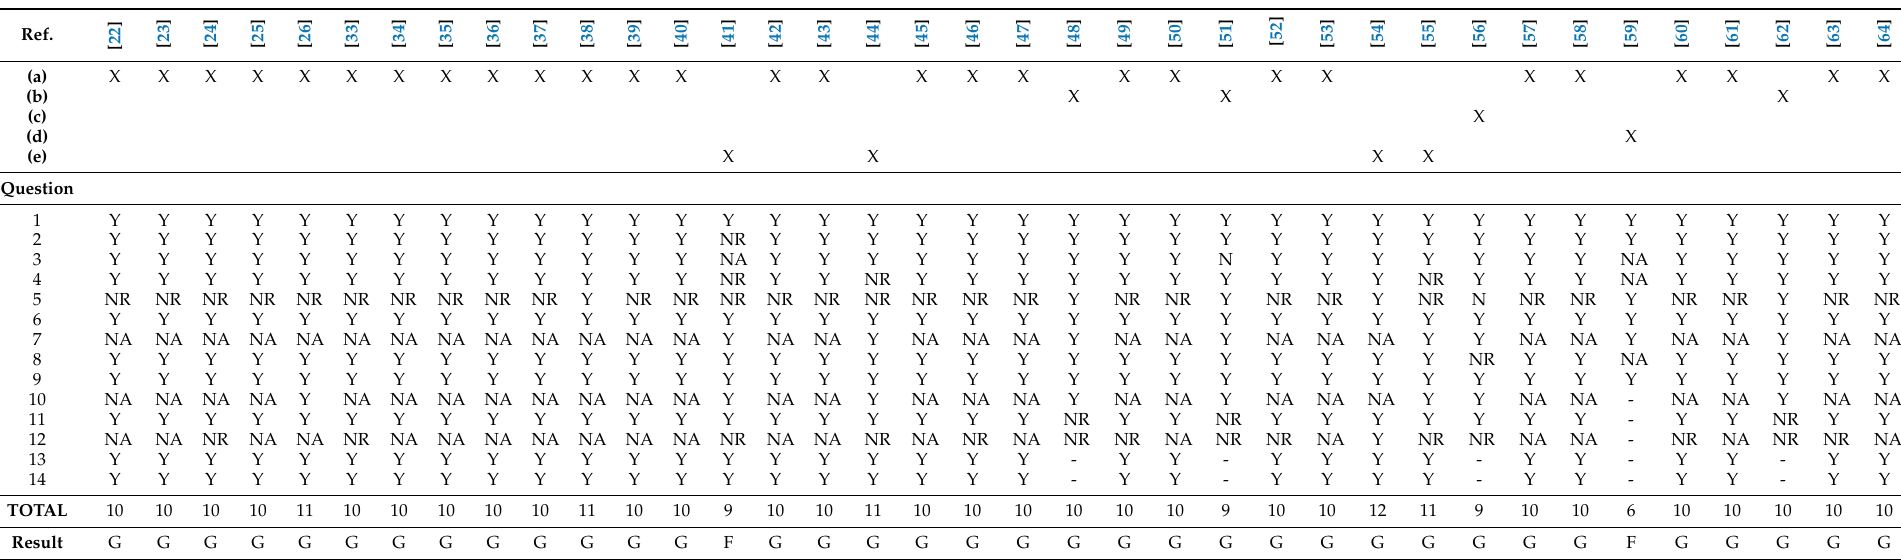
Table A2. Studies quality assessment by NHLBI